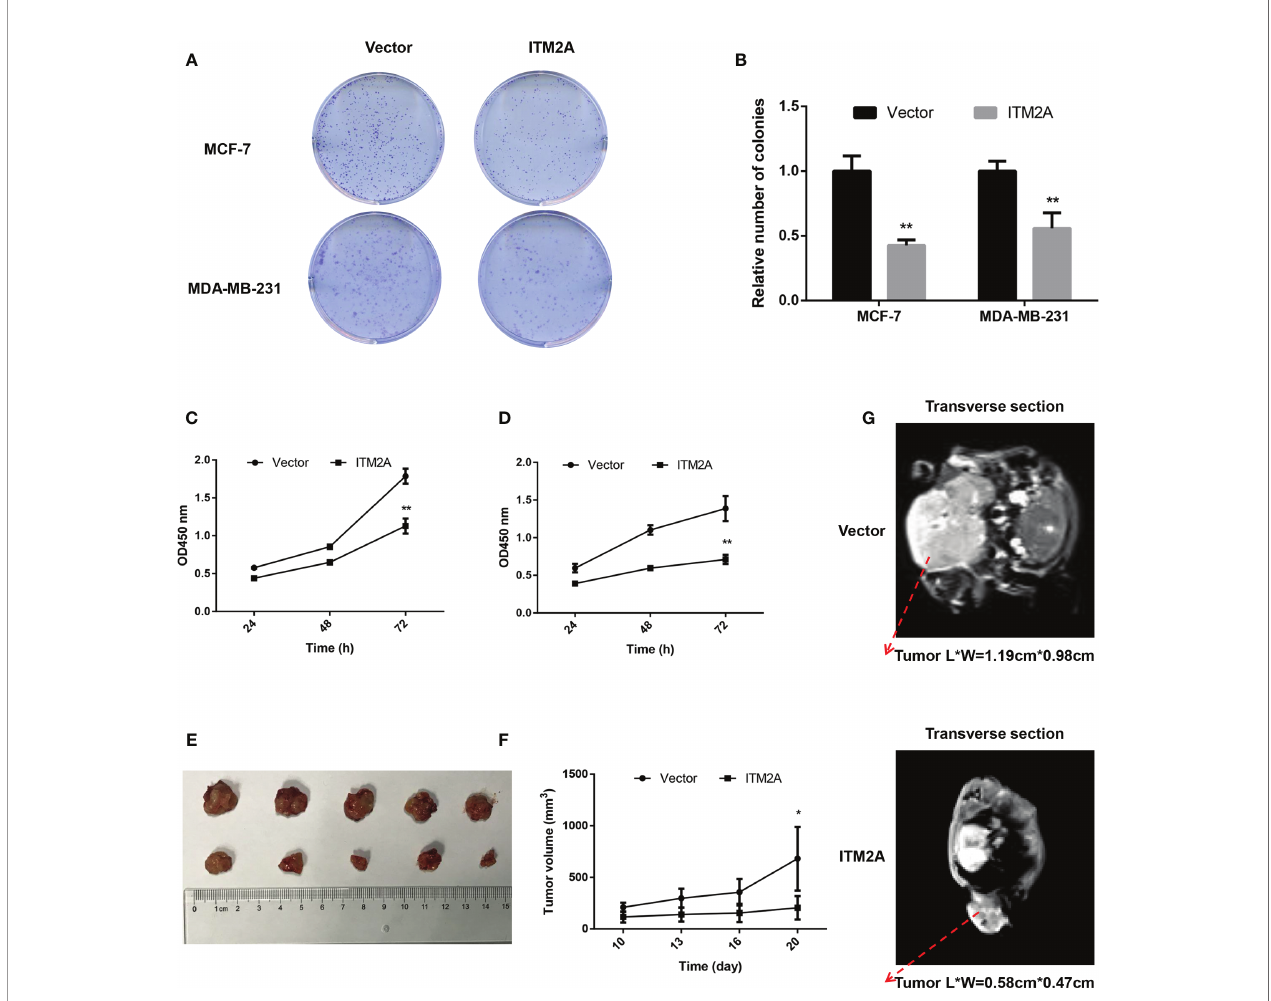
FIGURE 3 | ITM2A overexpression decreased proliferation of breast cancer in vitro and vivo. (A, B) Clone formation was stained with crystal violet 14 days after seeded. (C, D) Growth curves of MCF-7 (left) and MDA-MB-231 cells (right) transfected with the indicated plasmid were measured by CCK-8 assay. (E-G) ITM2A expression inhibited the proliferation of breast cancer cells in vivo . (E) Photographs of dissected tumors from sacri fi ced mice. (F) Growth curves of indicated tumors in BALB/c null mice. (G) Representative images of enhanced MRI in transverse section. “ L ” represents the major tumor axis and “ W ” represents the minor tumor axis. *p < 0.05, **p <